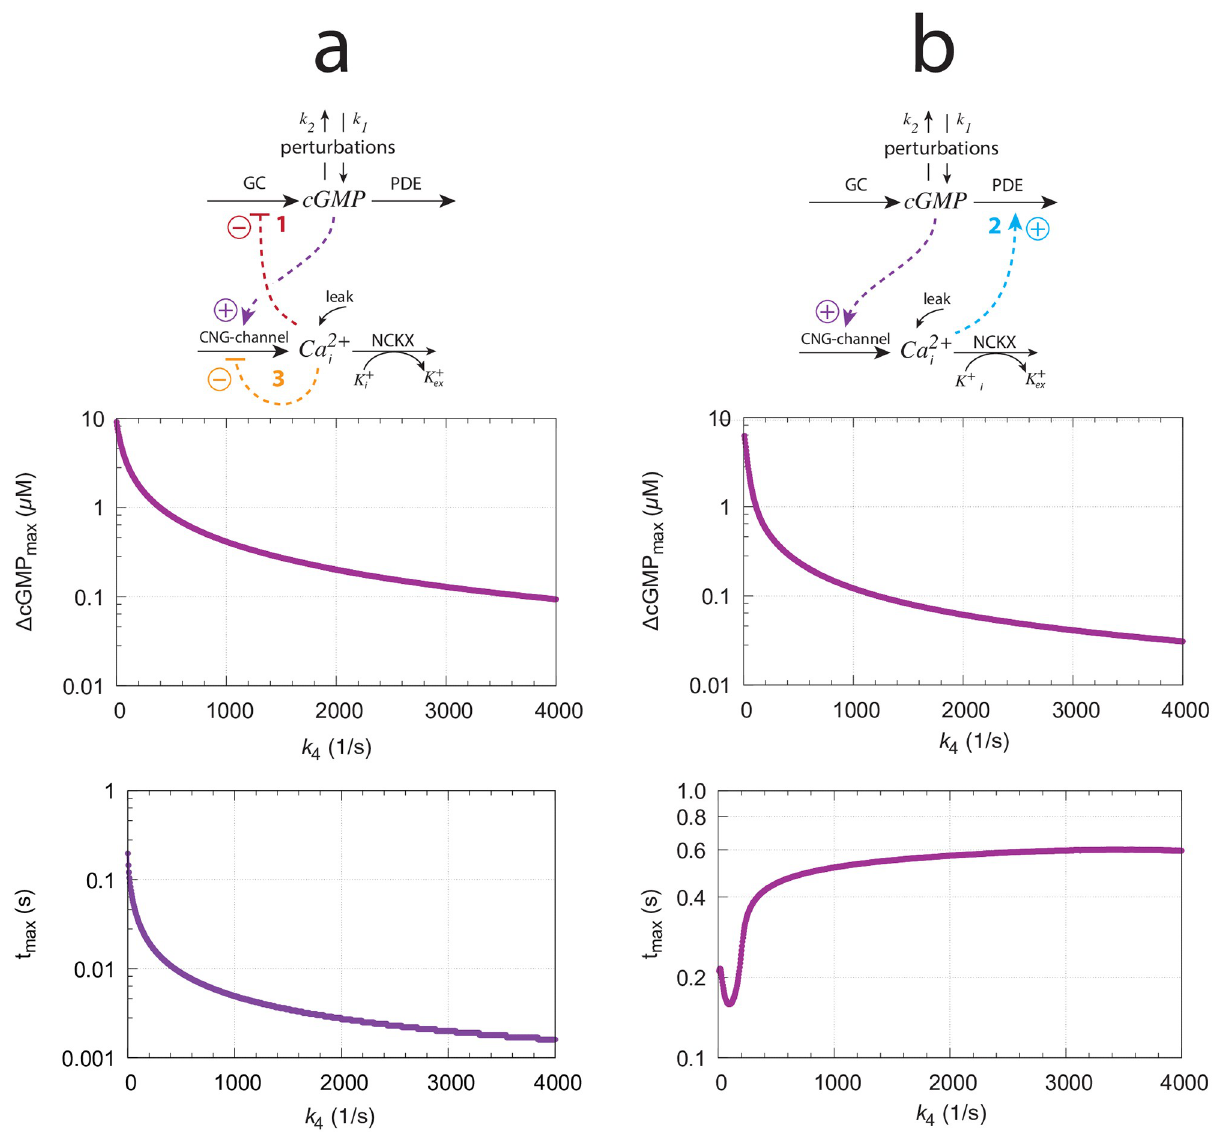
Fig 20. The model’s resetting behavior for different feedback arrangements when applying a 1.0 ! 50.0 s − 1 step in k 2 as a function of backgrounds k 4 . (a) Feedback loops 1 and 3 are combined. (b) Feedback 2 only. Used parameter values, rate constants, and definition of Δ cGMP and t max are as in Fig